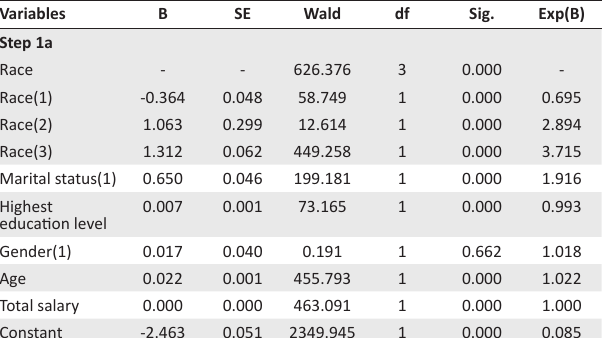
TABLE 4 : Determinants of demand for an investment account-logit estimate.